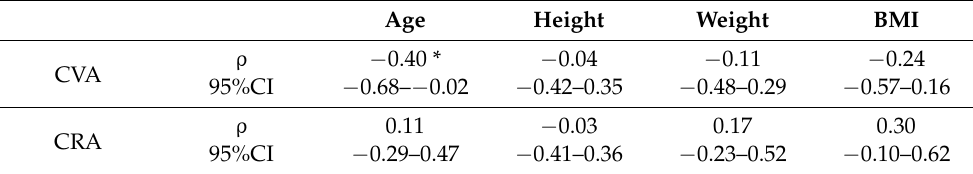
Table 3. Spearman rank correlation between CVA, CRA, and demographic data ( n = 26). Age